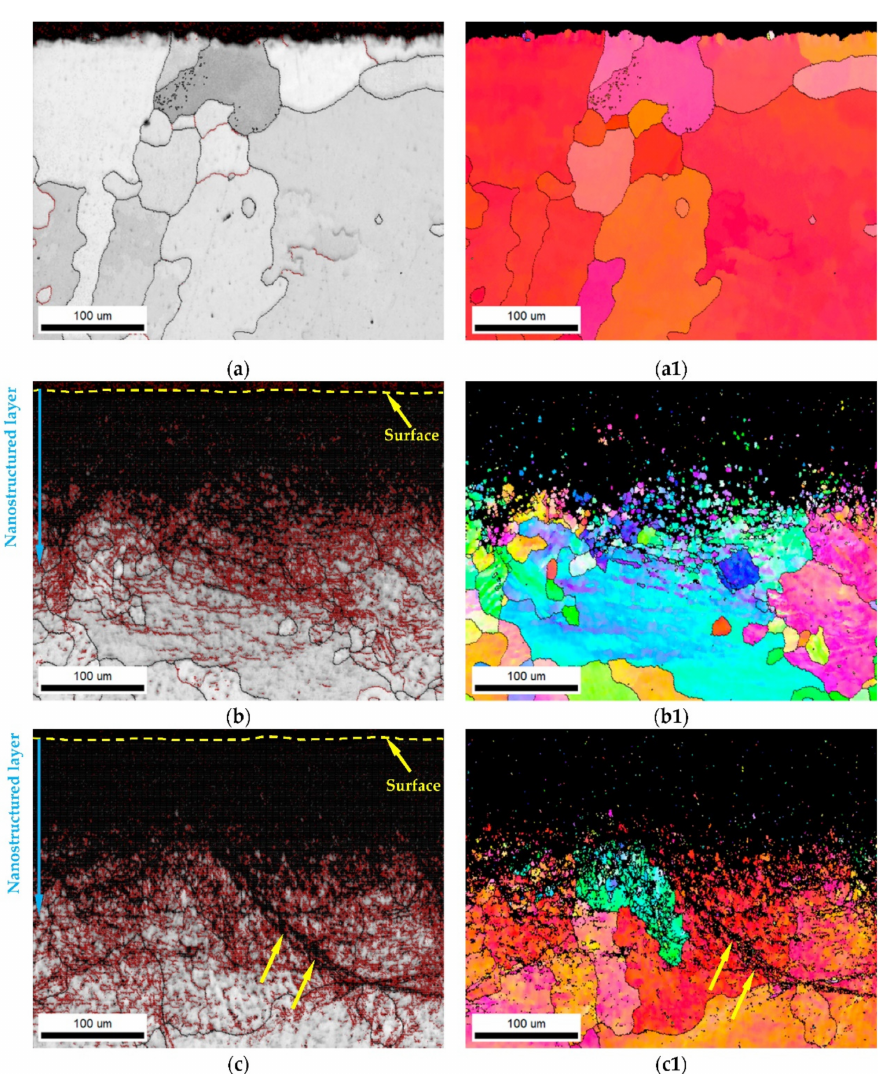
Figure 7. Comparison in EBSD results of the untreated ( a , a1 ), UNSM-treated at RT ( b , b1 ) and UNSM-treated at HT ( c , c1 )